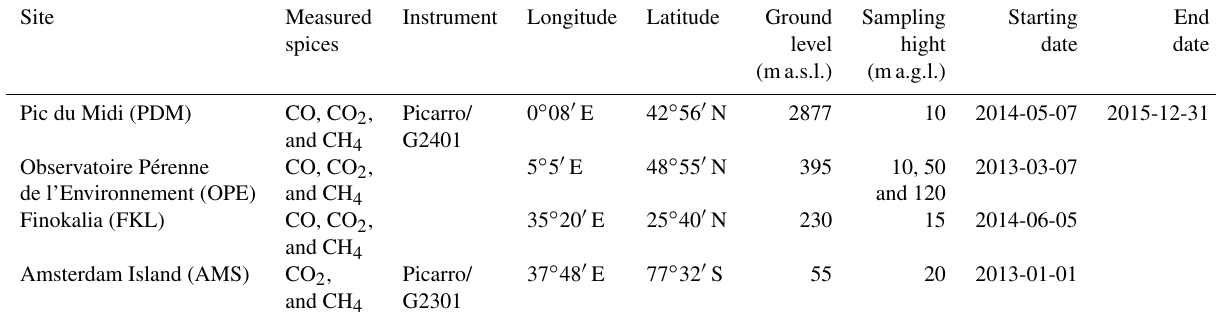
Table 1. Measurement sites